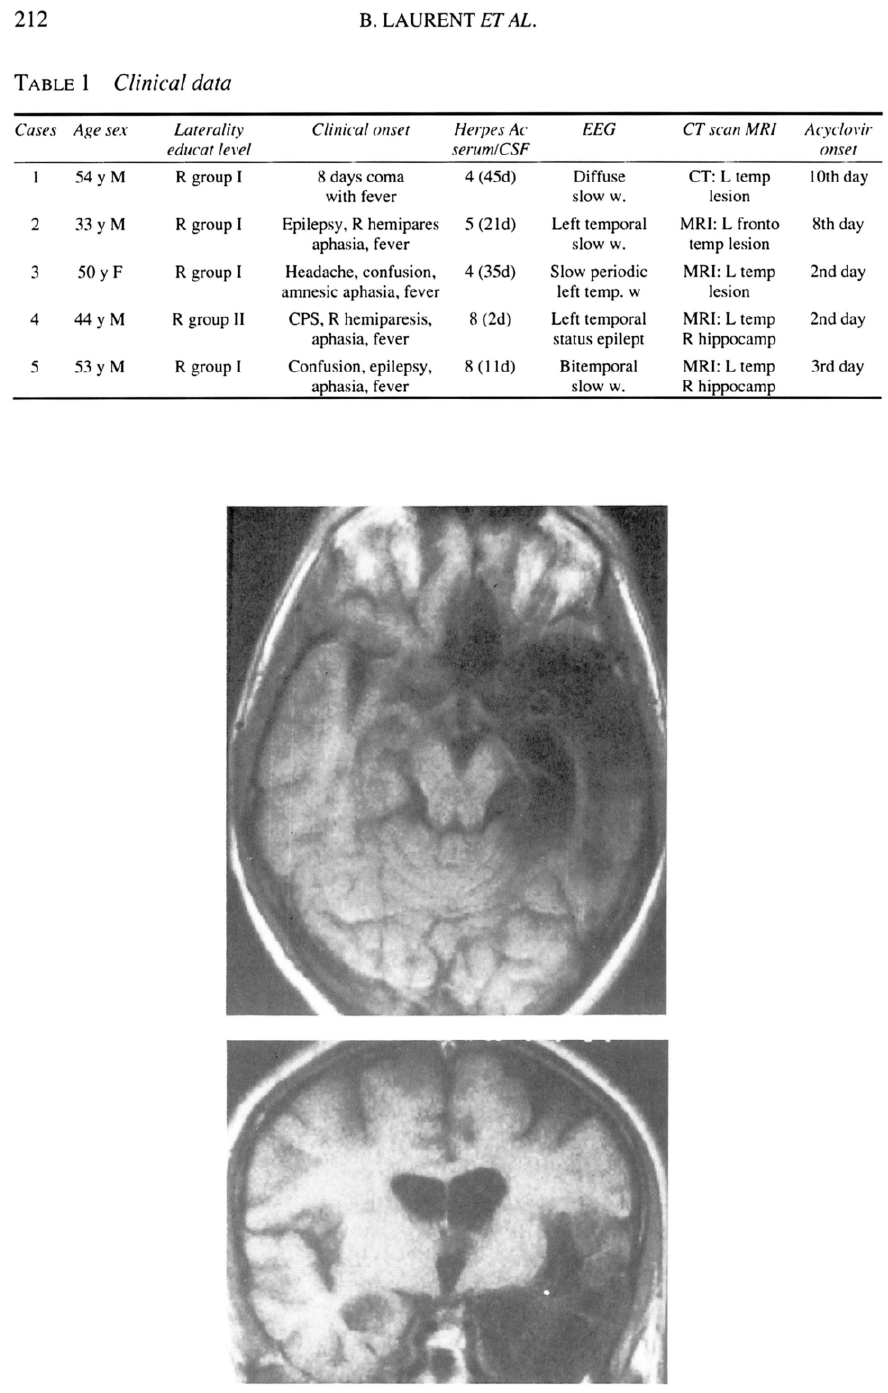
FIG. 1. Case 2: MRI T I weighted (2 years after onset: horizontal and coronal sections showing hyposignal in all the left temporal lobe with a small hyposignal in the right amygdala and septal